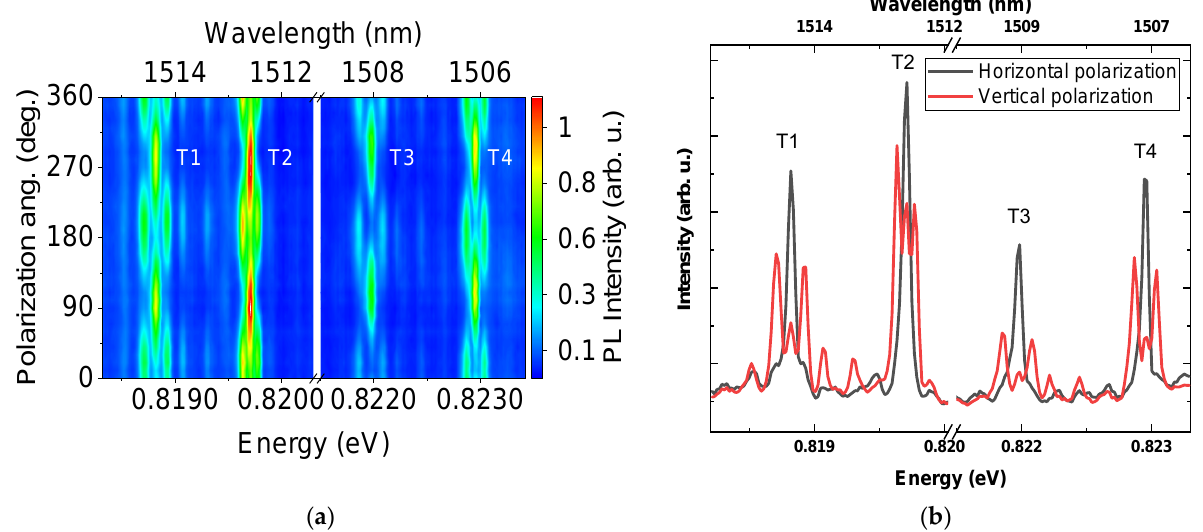
Figure 3. ( a ) Polarization-resolved photoluminescence spectra in a magnetic field of B = 5 T in Voigt configuration, showing pattern characteristic for charged exciton emission. ( b ) PL spectra for two orthogonal polarizations in Voigt configuration at magnetic field of 5.0 T.